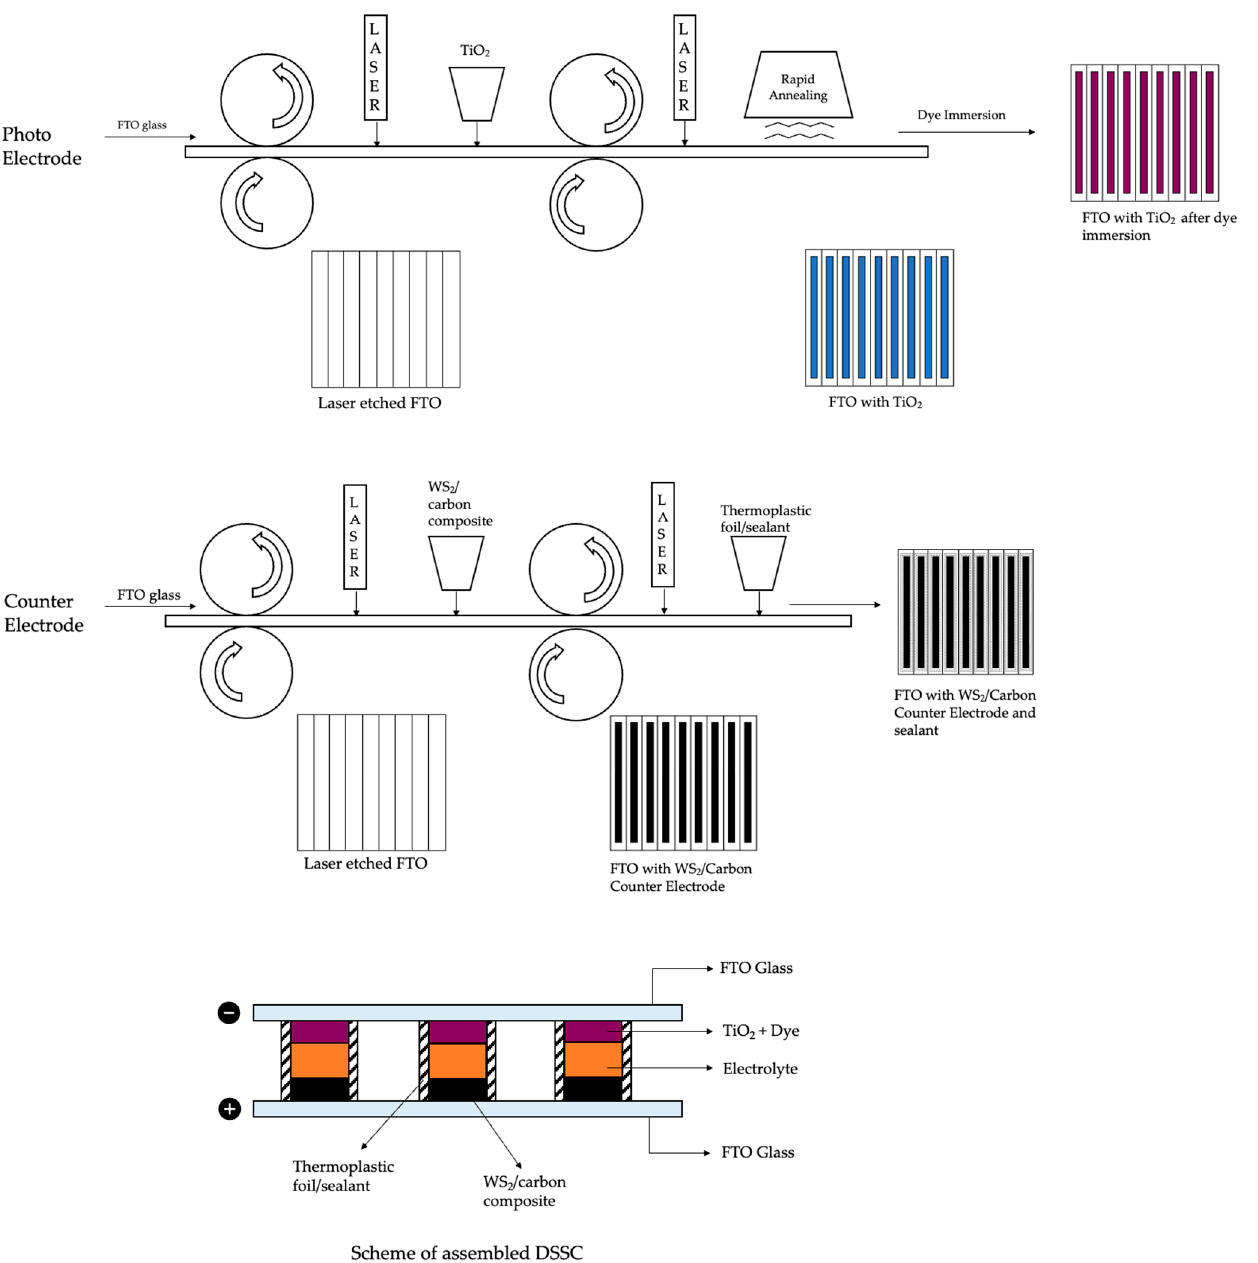
Figure 3. Preparation and assembly of DSSC module.